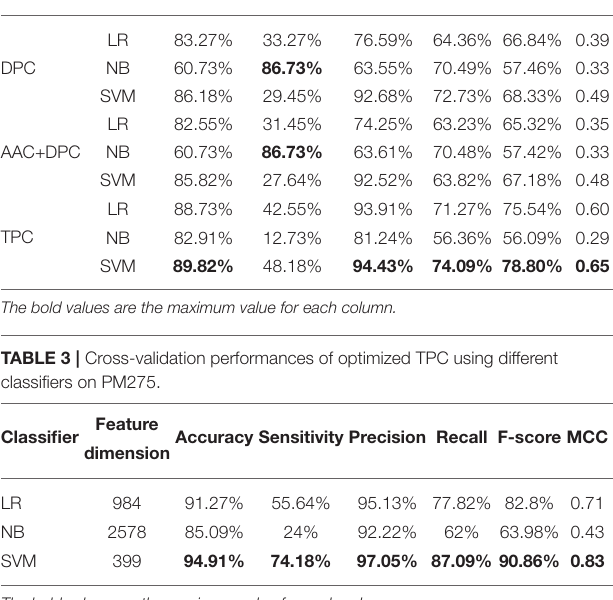
TABLE 2 | Cross-validation performances of DPC, TPC, and combination features using different classifiers on PM275. Feature vector